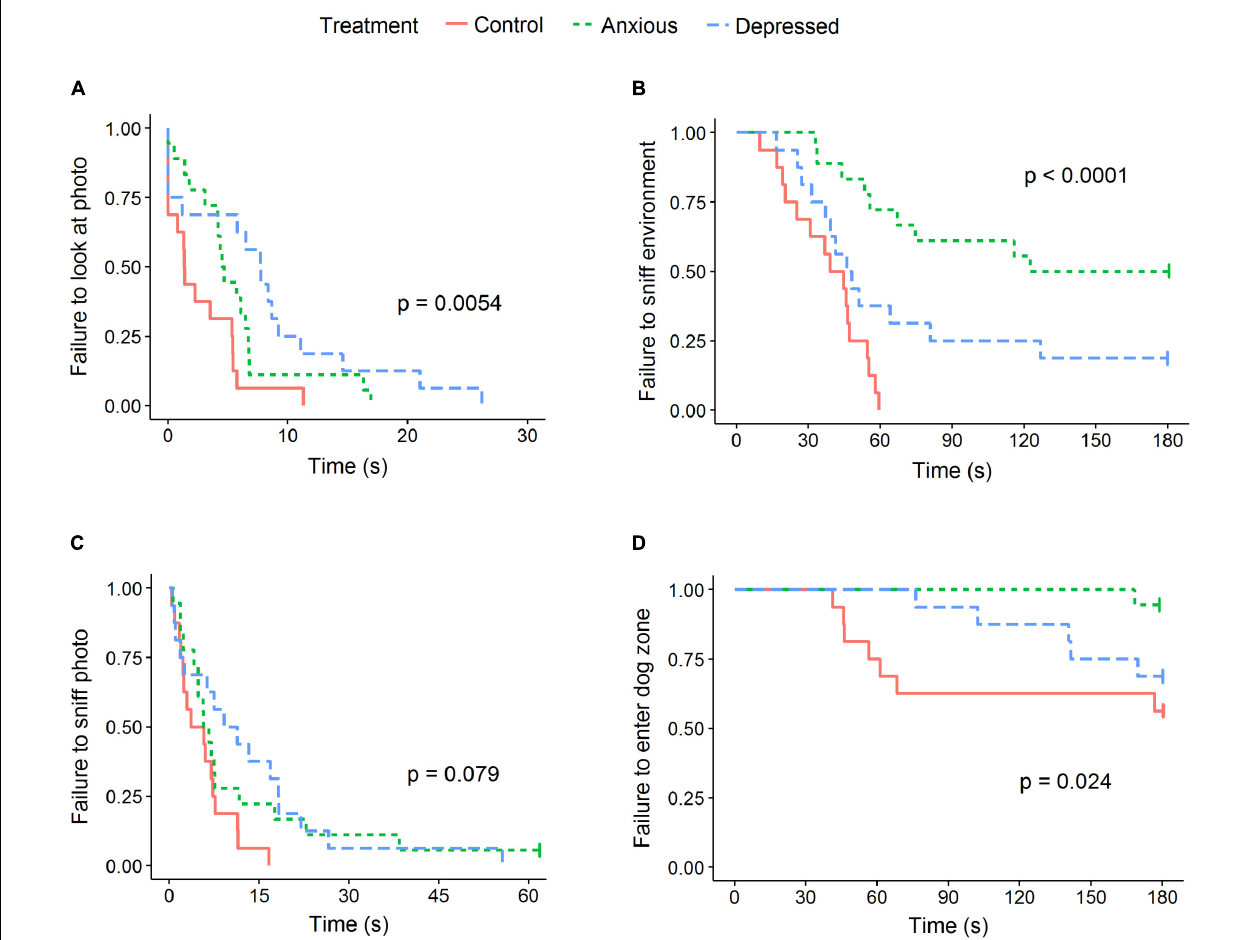
FIGURE 4 | Kaplan–Meier curves for latency to look at the photo (A) , sniff the environment (B) , sniff the photo (C) , and enter the zone closest to the dog (D) . Each time an animal exhibited the given behavior, the probability on the Y -axis drops. Latencies to look at and sniff the photo are given for the first 60 s of testing only as no further events occurred after this time. The censored result in the anxious group for latency to sniff the photo remained censored for the duration of the 180 s